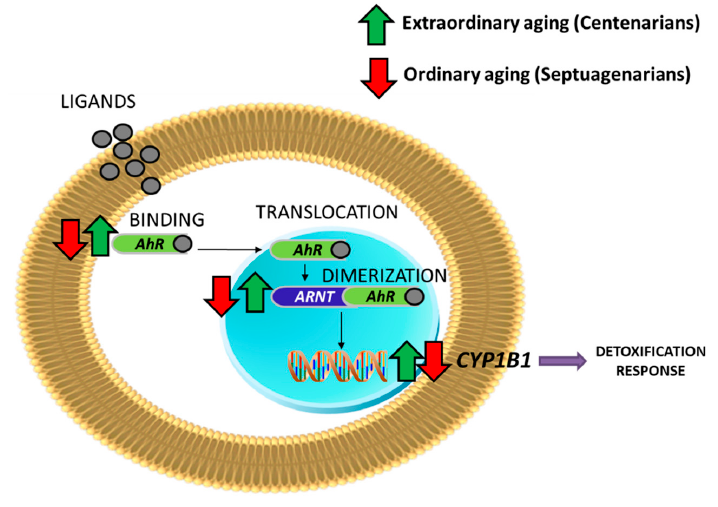
Figure 4. AhR signaling in centenarians is up-regulated in comparison with septuagenarians.